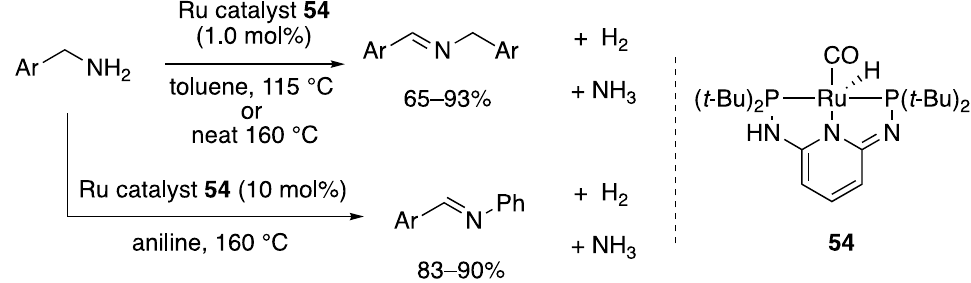
Figure 4. Mn- and Ir-pincer complexes that exhibit catalytic activity in dehydrogenative imine formation from alcohols and amines.